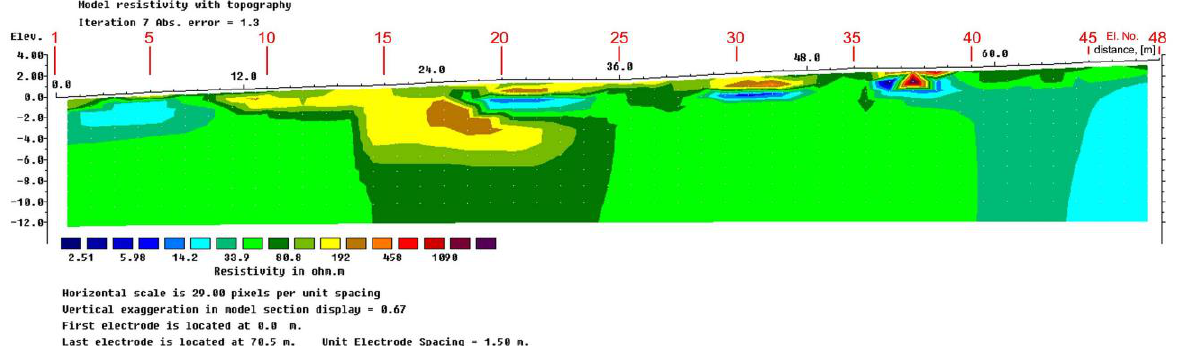
Figure 14—the ERT profile based on measurement with the Dipole–Dipole array.